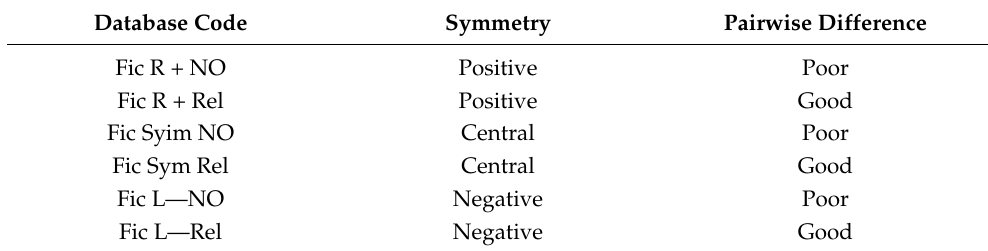
Table 1. Codes and characteristics of databases.